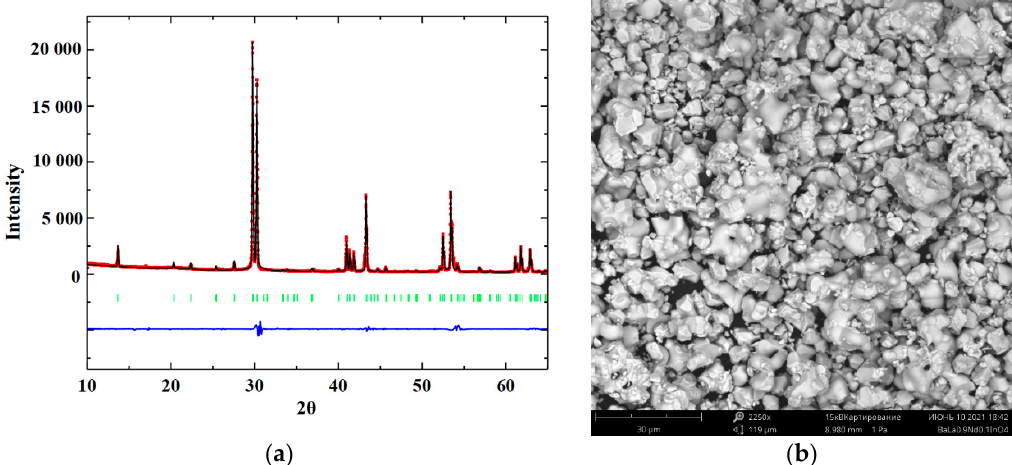
Figure 2. The XRD-patterns of isovalent-doped compositions BaLa 0.9 Nd 0.1 InO 4 , BaLaIn 0.9 Sc 0.1 O 4 , BaLaIn 0.9 Y 0.1 O 4 ( a ) and lattice parameters changes of these compositions compared with BaLaInO 4 ( b ).